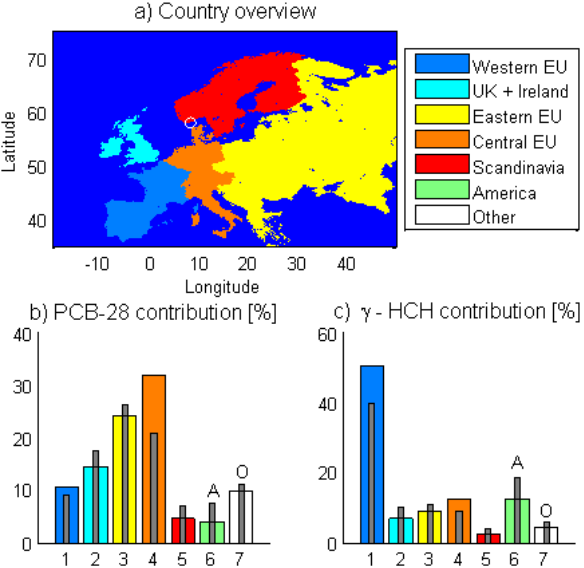
Fig. 11. Same as Fig. 12 but for γ -HCH.